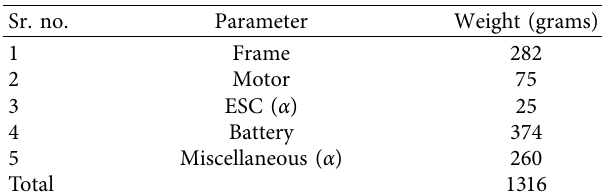
Figure 10: IMU Sensor Data on Inclined Surface with and without filter. Table 6: System weight